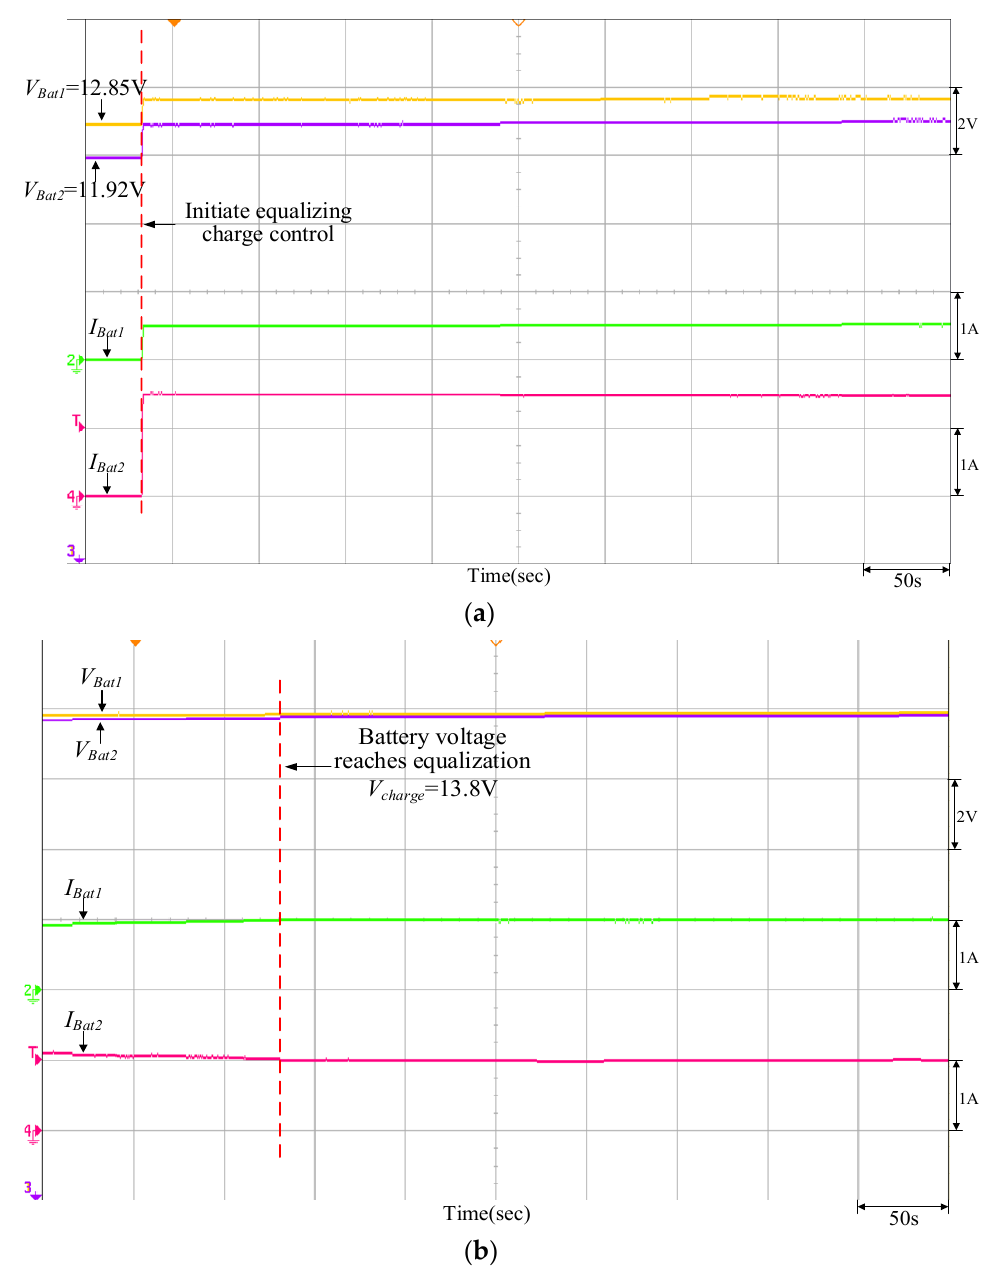
Figure 23. Equalizing charge control response of the traditional P-I controller when V Bat1 = 11.58 V and V Bat2 = 12.65 V: ( a ) initiate equalizing charge control; ( b ) reach equalizing charge equalization.